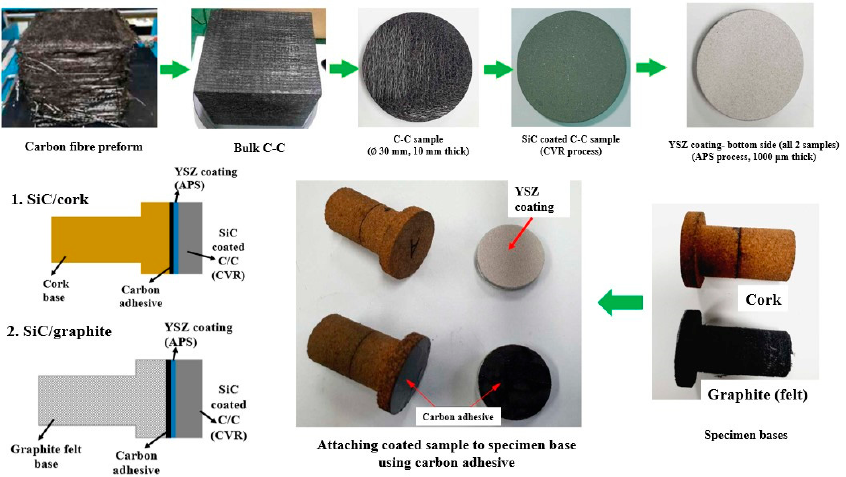
Figure 2. SiC-coated C–C specimen fabrication process.